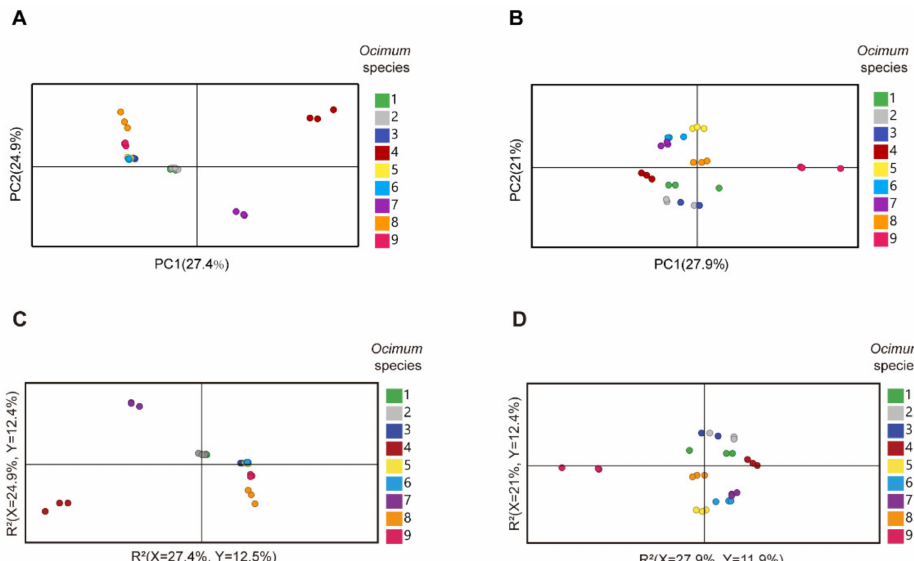
Figure 3. Multivariate analysis of metabolome and volatilome data of different basil species. ( A ): PCA (principal component analysis) plot of volatilome data. ( B ): PCA plot of metabolome data. ( C ): PLS-DA (partial least squares discriminant analysis) plot of volatilome data. ( D ): PLS-DA plot of metabolome